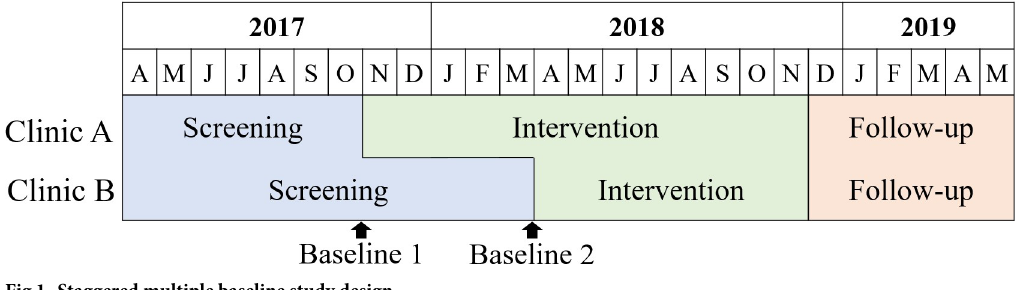
Fig 1. Staggered multiple baseline study